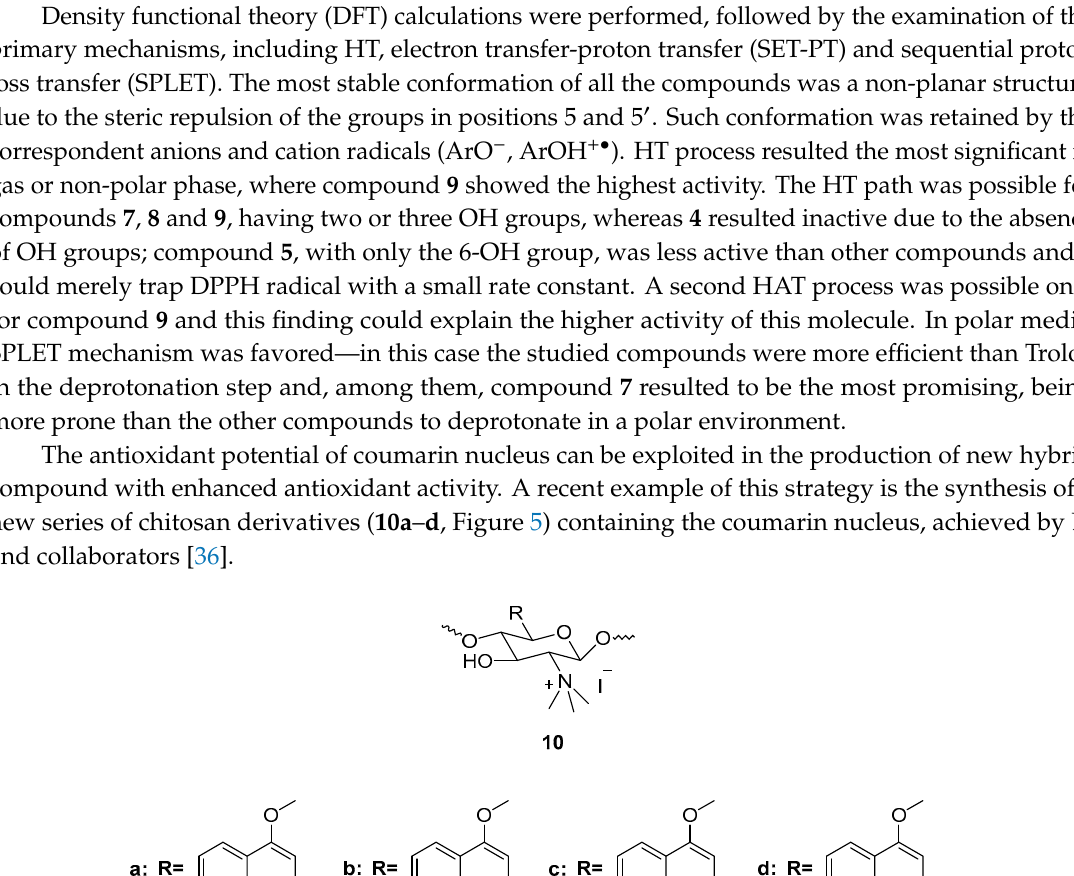
Figure 4. Chemical structure of coumarin-fused coumarins 4 – 9 .